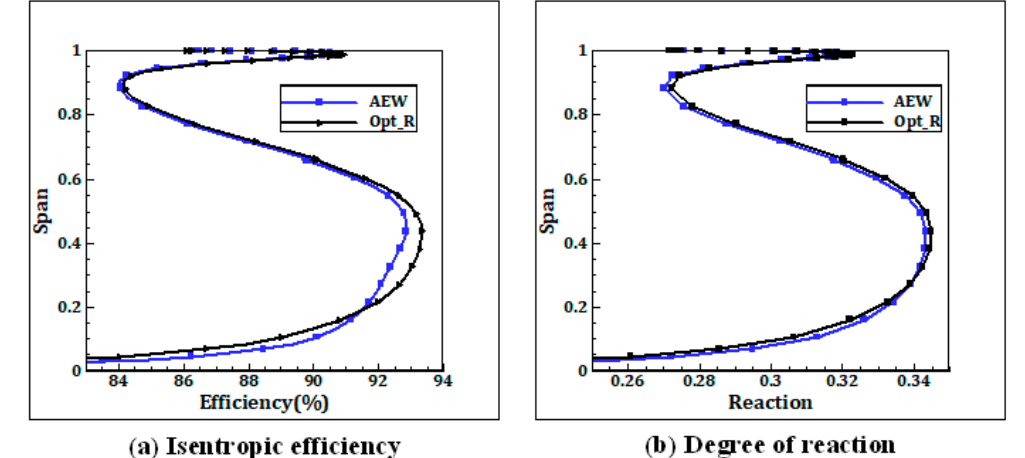
Figure 14. ( a,b ) Contours of isentropic Mach number at the rotor hub. The change in entropy at the outlet of the rotor is shown in Figure 15a,b. The combined effect of lower passage vortex and the stator wake are marked with the ‘black square’. The entropy generation